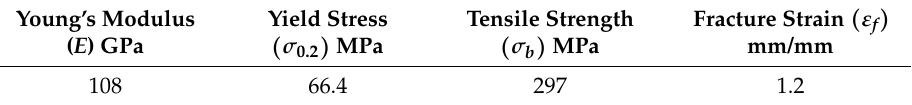
Table 3. Mechanical properties of the pure copper T2.